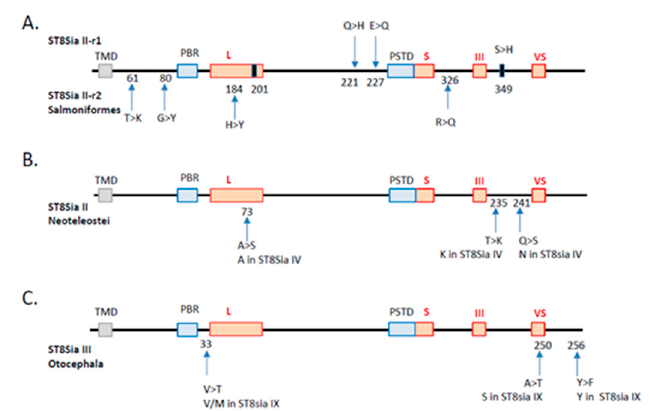
Figure 5. Substitution rate analysis of the impact of st8sia gene duplications and losses. The sialylmotifs are indicated by red boxes and the transmembrane domain by a grey box. ( A ) Duplication of st8sia2 genes in Salmoniformes. The substitutions observed in ST8Sia II-r1 and ST8Sia II-r2 are indicated by an arrow above and below, respectively. The position of the substitutions corresponds to the alignment in Supplemental Data 2. The black rectangles correspond to convergent mutations retrieved in both sequences. In T > K, for example, T is the ancestral state and K is the derived one. ( B ) Impact of st8sia4 gene loss in Neoteleostei on the remaining fish ST8Sia II sequences. The code for substitution is the same as in A. The corresponding amino acid present in the paralogue ST8Sia IV sequence is given below. ( C ) Impact of st8sia9 gene loss in Otocephala on the remaining fish ST8Sia III sequences (same abbreviations as in B).